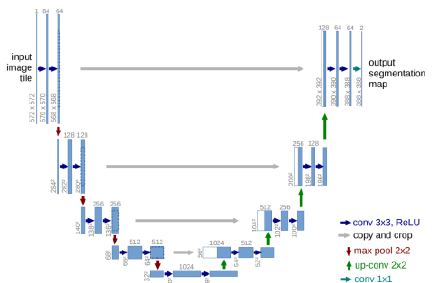
Figure 1. UNet architecture (Ronneberger et al.,